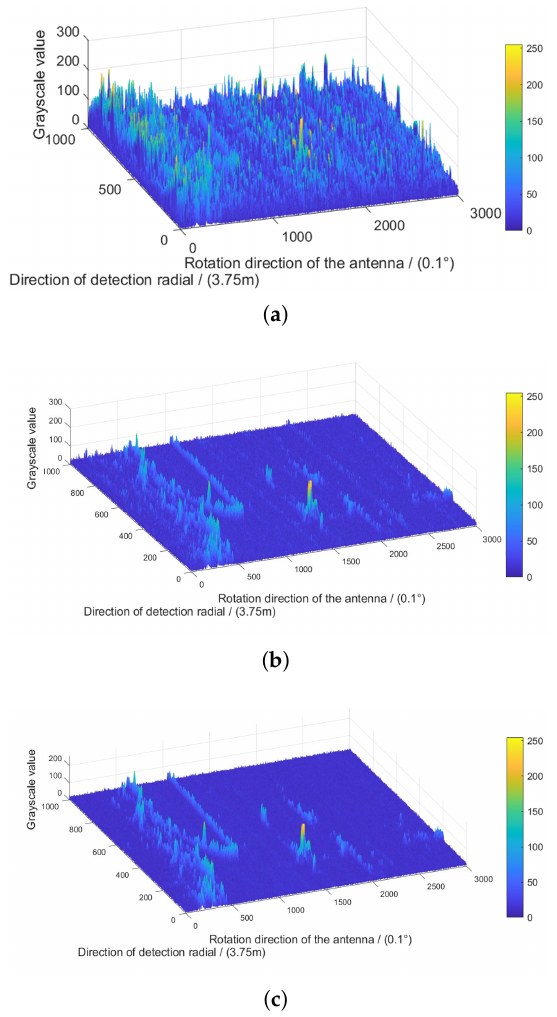
Figure 6. Comparison of mesh surface graphs between algorithms. ( a ) Mesh surface graph of original radar image, ( b ) mesh surface graph of the image processed by the adaptive median filtering algorithm, ( c ) mesh surface graph of the image processed by the proposed